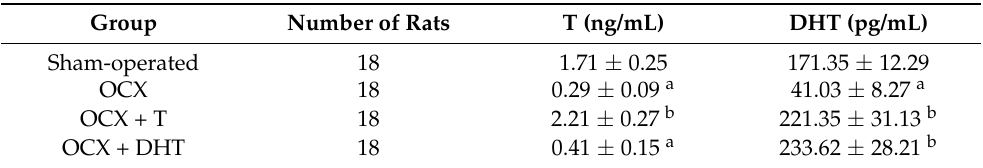
Table 2. Serum androgen concentrations of adolescent rats after orchiectomy (OCX), treatment with testosterone (T), dihydrotestosterone (DHT). Values represented as the mean ± SEM. Group Number of Rats T (ng/mL) DHT (pg/mL) Sham-operated 18 1.71 ± 0.25 171.35 ± 12.29 OCX 18 0.29 ± 0.09 a 41.03 ± 8.27 a OCX + T 18 2.21 ± 0.27 b 221.35 ± 31.13 b OCX + DHT 18 0.41 ± 0.15 a 233.62 ± 28.21